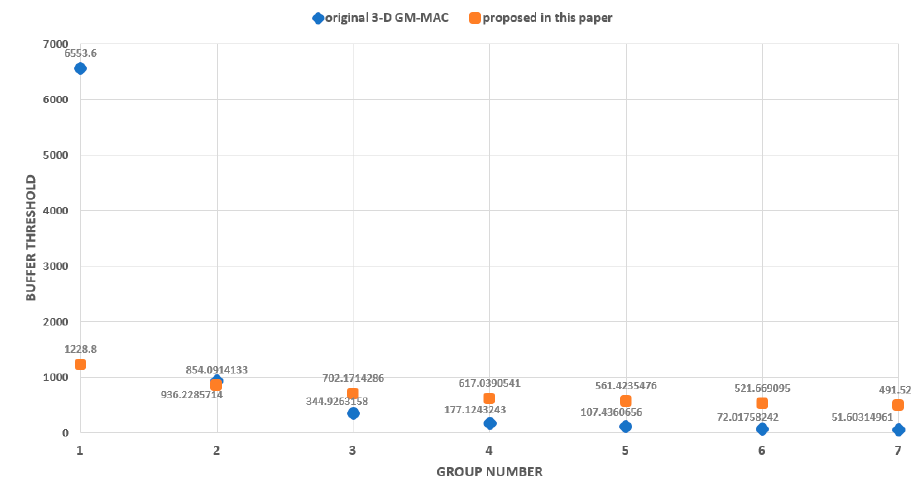
Figure 18. Bu ff er threshold. Figure 18. Buffer threshold.